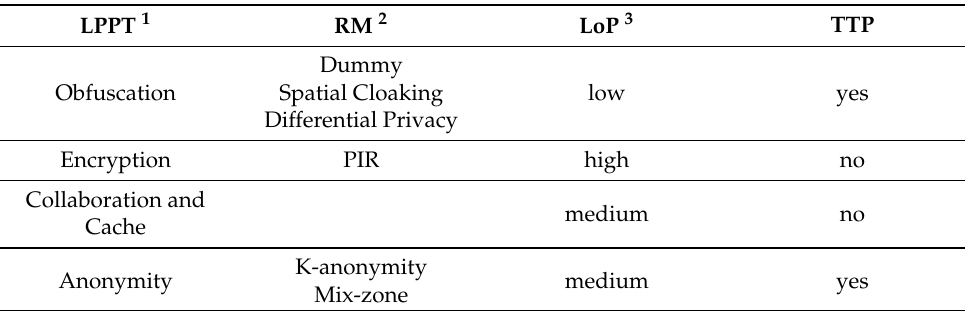
Table 1. The comparison among four privacy protection